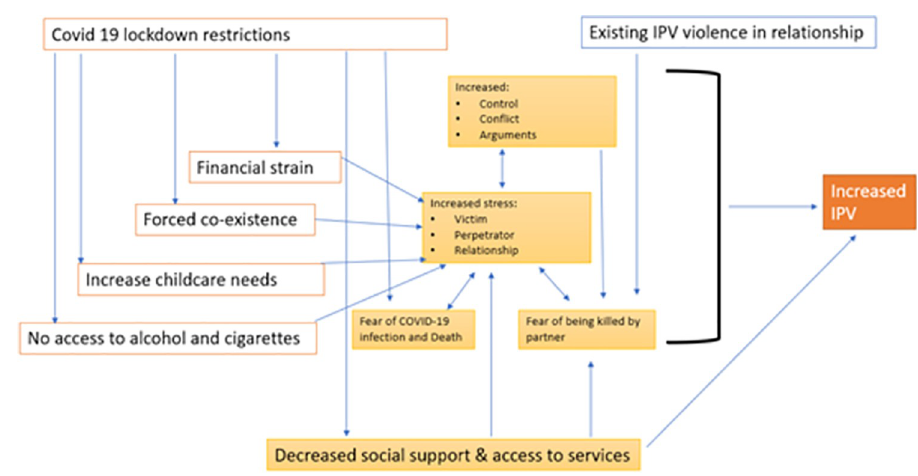
Fig 1. How COVID-19 restrictions influenced household dynamics and increased